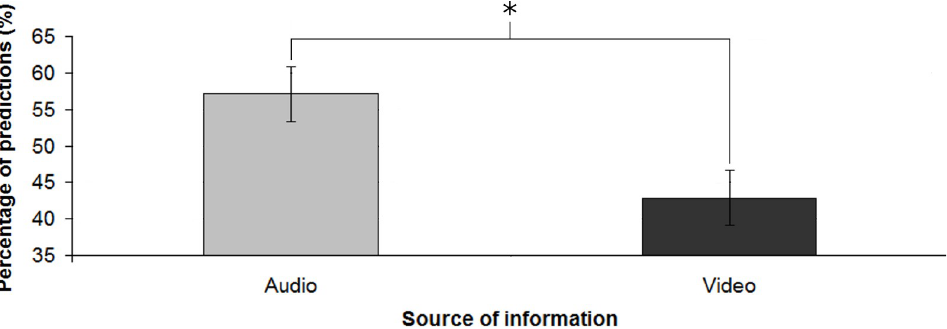
Fig 5. Percentage of predictions in line with the two sources of information for the incongruent stimuli. Error bars show the standard error of the mean; � denotes statistical significance.